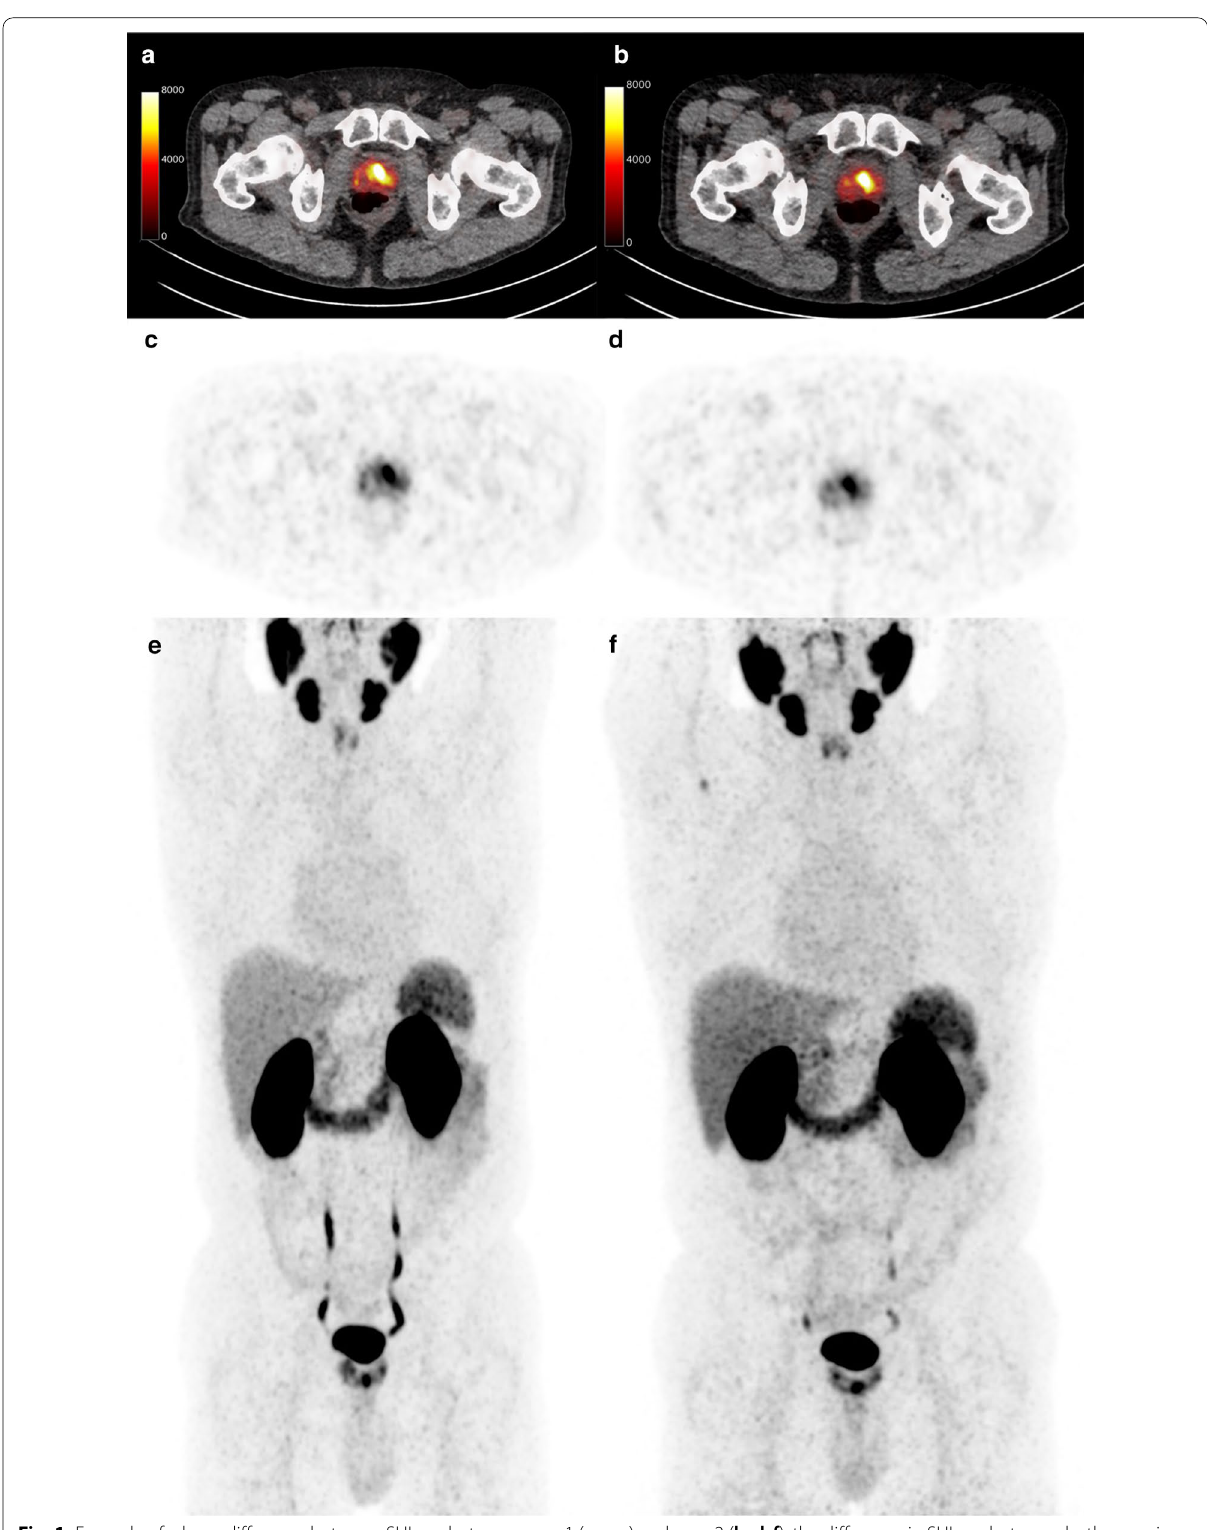
Fig. 1 Example of a large difference between SUL peak between scan 1 ( a , c , e ) and scan 2 ( b , d , f ), the difference in SUL peak between both scans is